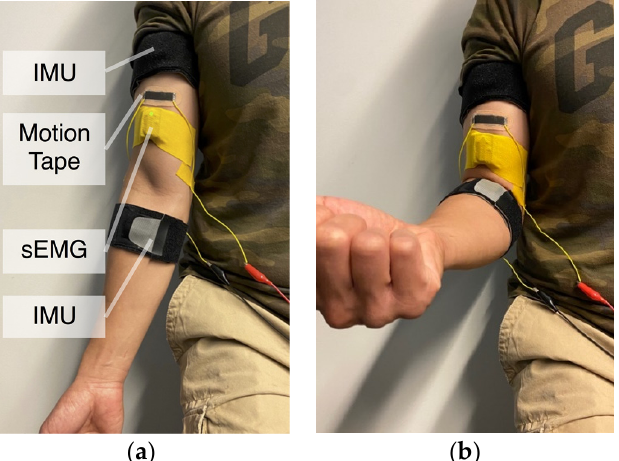
Figure 5. ( a ) Subjects wore Motion Tape perpendicular to the biceps brachii, along with an sEMG sensor and two IMUs, for ( b ) bicep curl muscle engagement verification tests.